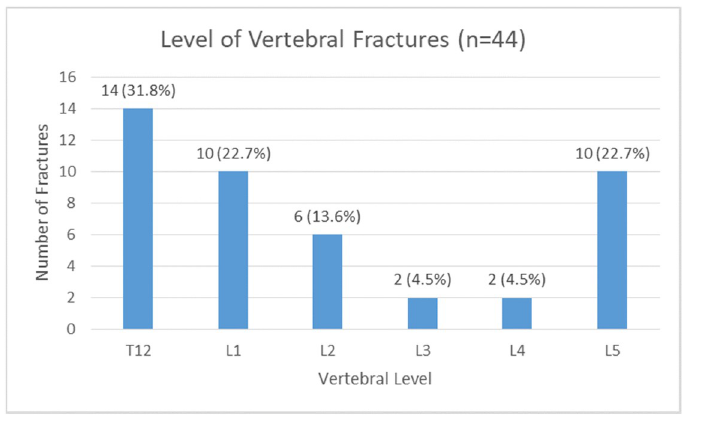
Fig 2. Level of vertebral fractures.